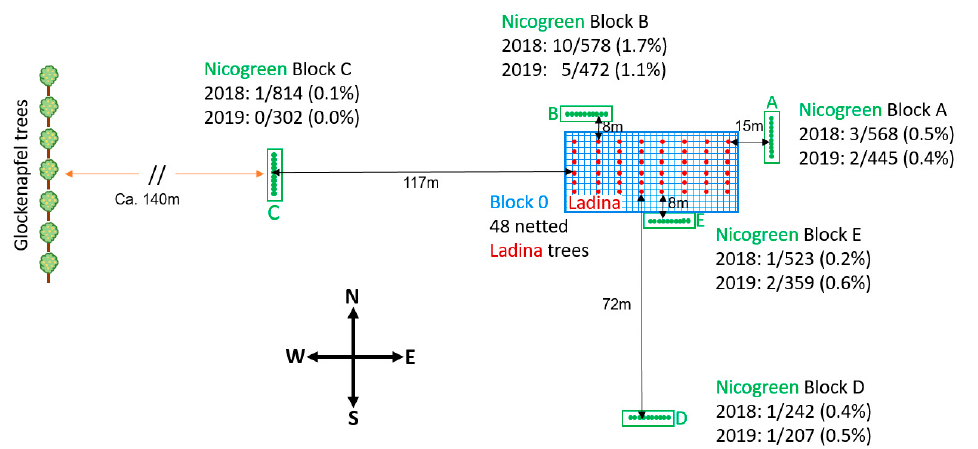
Figure 1. Experimental site layout and summary of outcrossing events. The number of ‘Nicogreen’ seedlings derived from a pollination with ‘Ladina’ (NL seedlings) out of the total number of ‘Nicogreen’ seedlings investigated is presented per year. Percentages in parentheses. Blue box: Block 0 with ‘Ladina’ trees (red dots). Green boxes: Blocks A to E of ‘Nicogreen’ trees (ten each). Black arrows: minimal distance (m) between a ‘Ladina’ tree and a ‘Nicogreen’ block. Orange arrow: minimal distance from ‘Glockenapfel’ trees to Block C (circa 140 m). Not to scale.